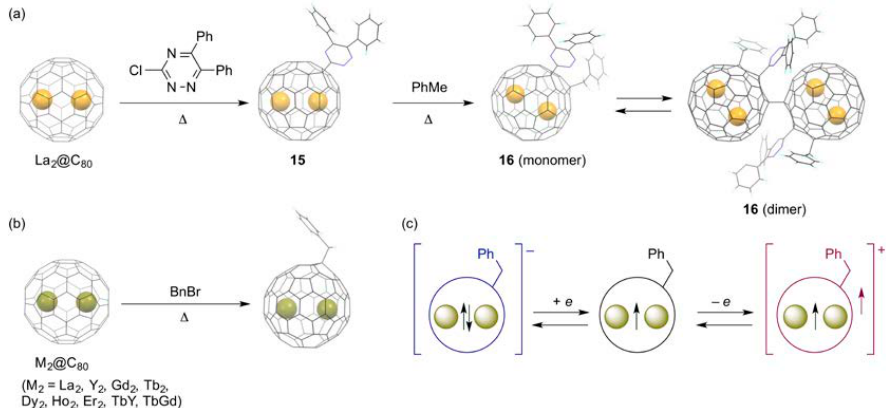
Figure 5. ( a ) Reaction of La 2 @C 80 with 3-chloro-5,6-diphenyltriazine, and reaction of 15 with toluene. ( b ) Benzylation of M 2 @C 80 . ( c ) Schematic description of the single-electron reduction and oxidation of M 2 @C 80 (CH 2